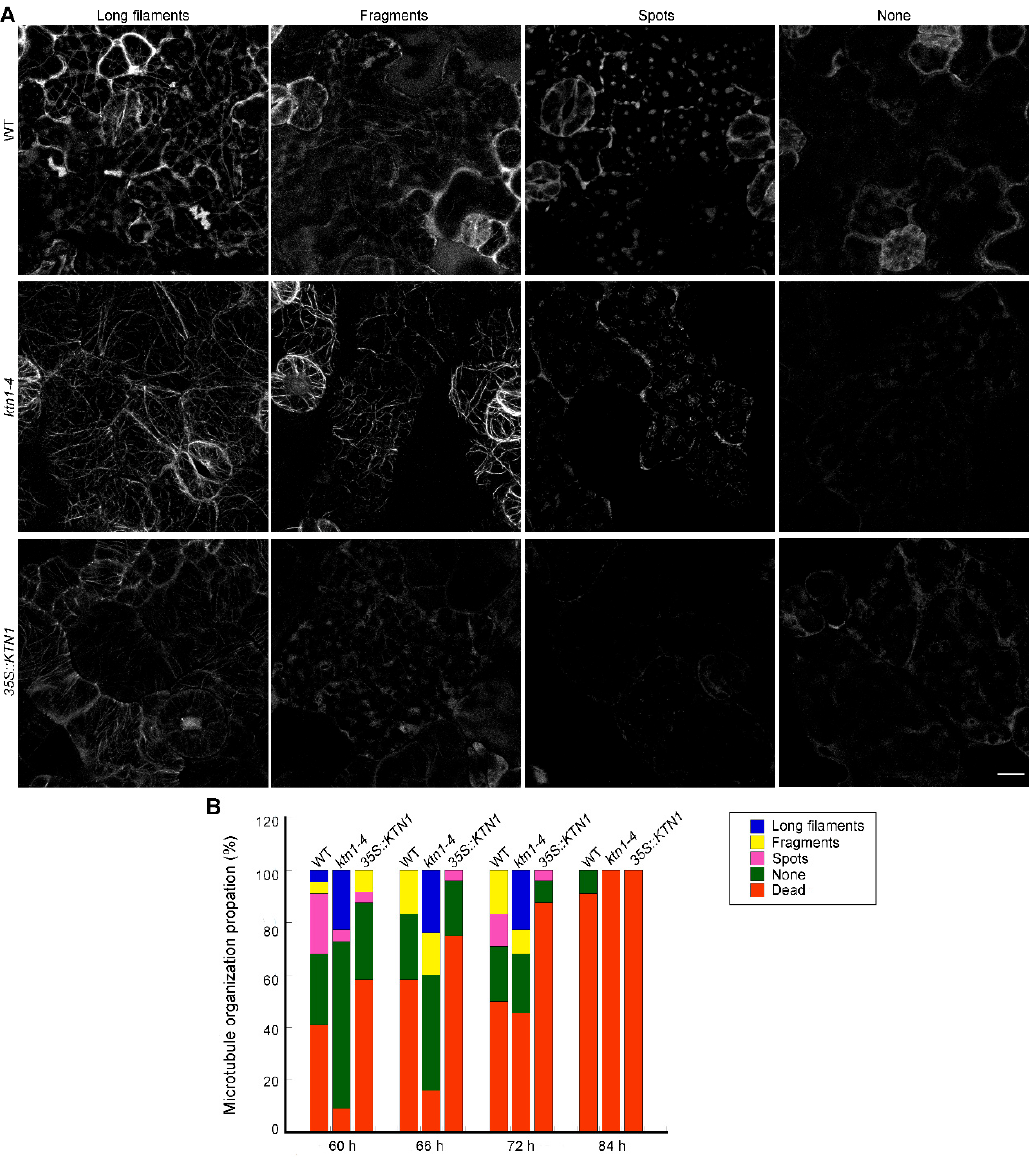
Figure 4. AtKTN1 regulates cortical microtubule organization in cotyledon pavement cells during the late stage of salt treatment (60–84 h). ( A ) Micrograph of different patterns of microtubule organization in cotyledon pavement cells during late stage of salt stress. Four-day-old seedlings of GFP-TUA6 labeled WT (Col-0), ktn1-4 and 35S::KTN1 were transferred onto 1/2 MS medium supplemented with 200 mM NaCl. Different representative patterns were indicated with long filaments, fragments, spots, or nothing. Scale bar = 10 µ m. ( B ) Quantification of the patterns of cortical microtubules arrays in ( A ) at indicated time. More than 11 seedlings for each line were observed at each indicated time.